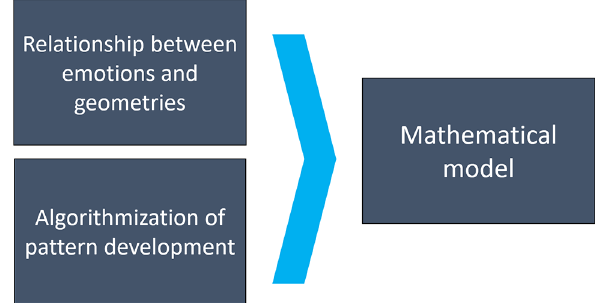
Fig. 5 Milestones of the